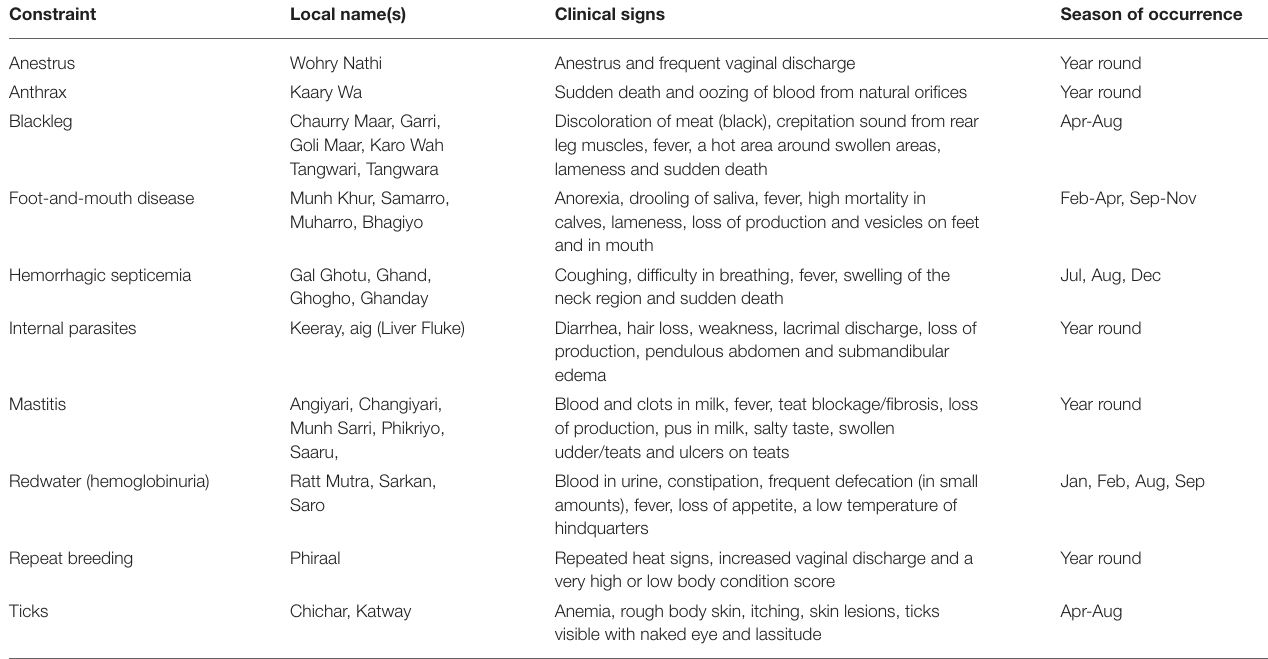
TABLE 2 | Description of local names and clinical signs of major bovine health and production constraints described by farmers and animal health professionals.